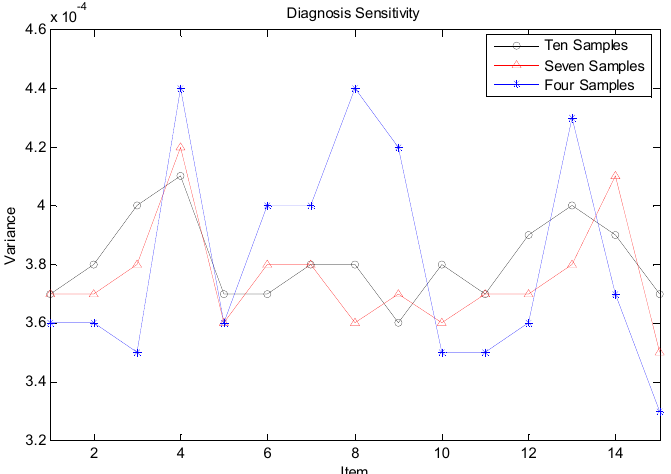
Figure 5. The variance curve of brine inlet water temperature T1 diagnosis efficiency test.